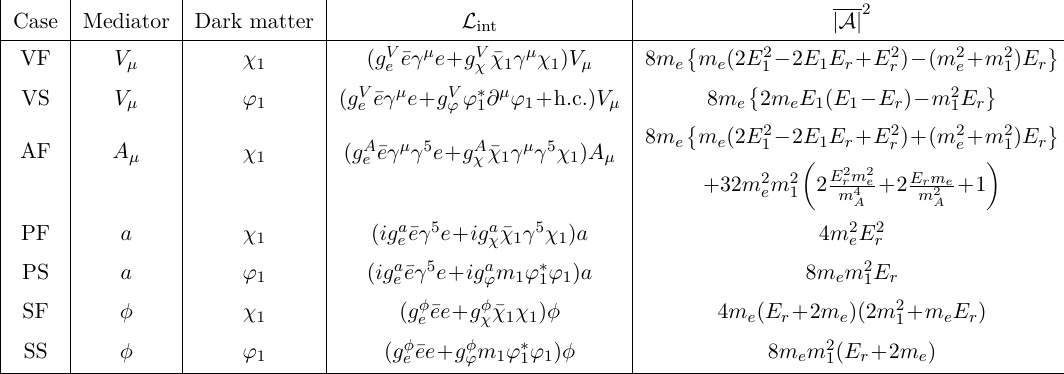
, A , a , and φ denote vector, axial- µ µ and ϕ denote (Dirac-)fermionic and 1 1